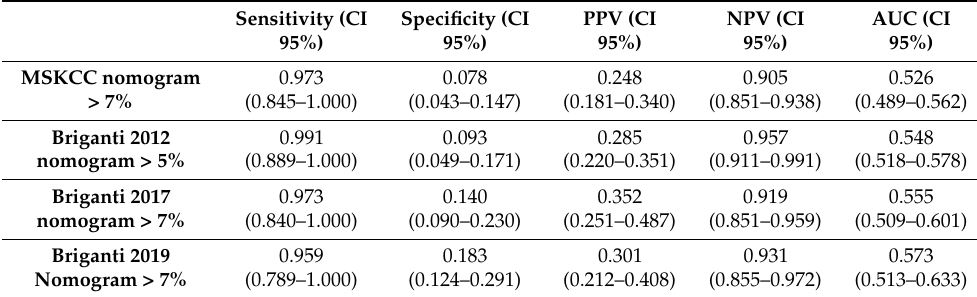
Table 4. Sensitivity, specificity, Positive predictive value (PPV), Negative predictive value (NPV), and AUC of different variables in predicting pN+ status at